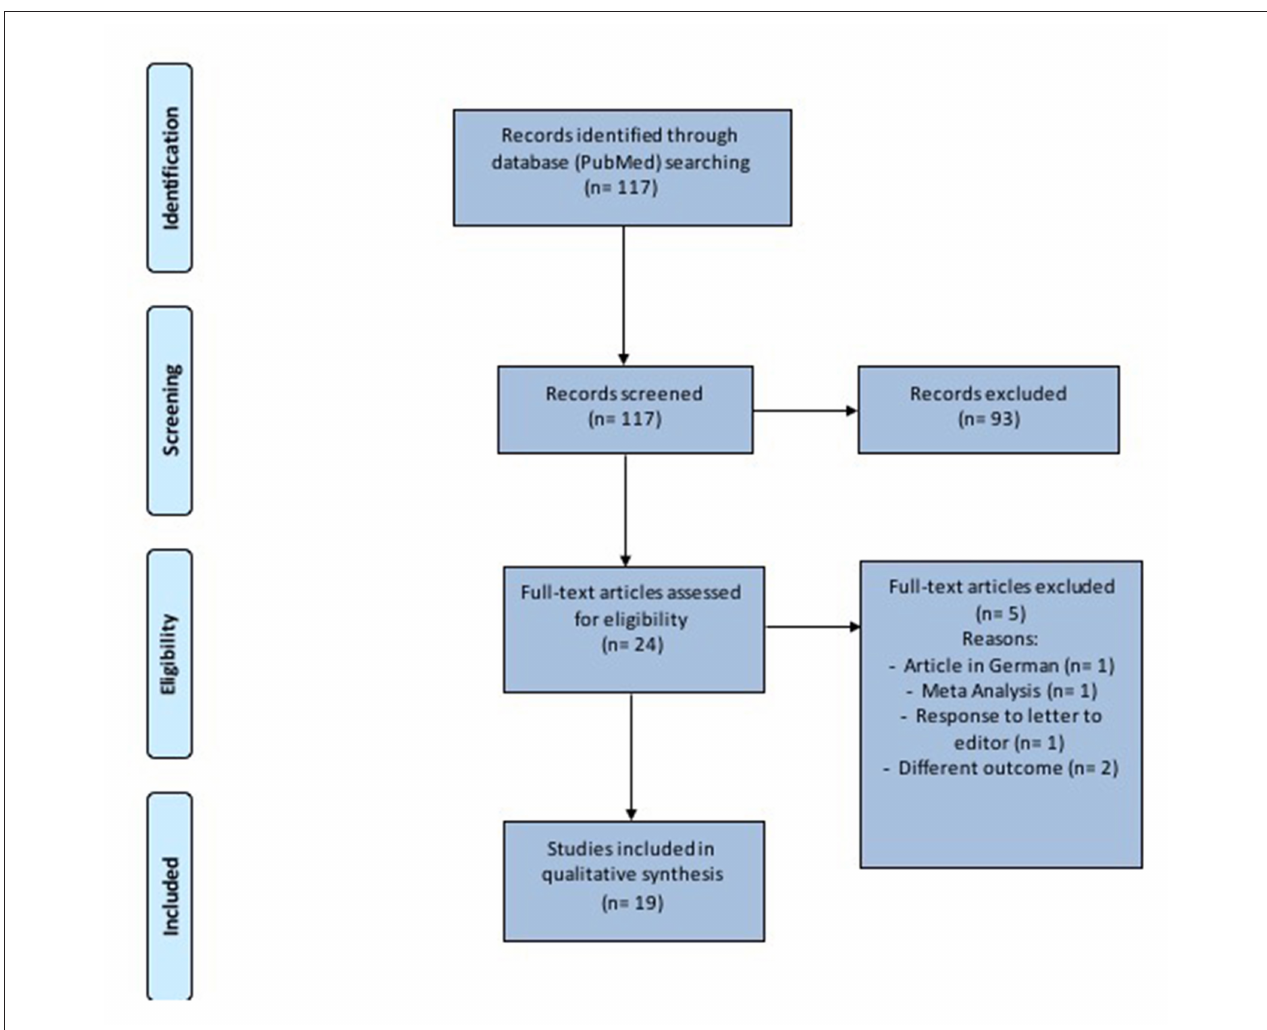
FIGURE 1 | Prisma diagram to illustrate the method used to select the articles.